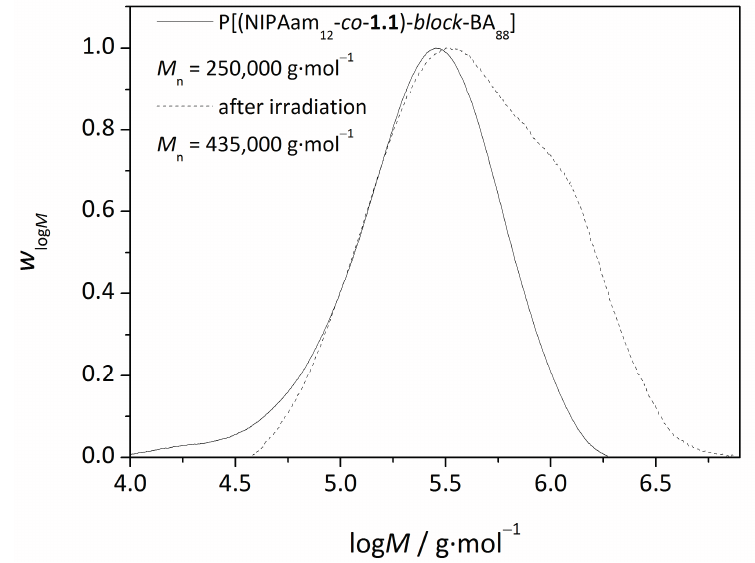
Figure 9. SEC-data, determined in THF, of a starpoly [(NIPAam- co - 1.1 ) 12 - block -BA 88 ] with a molecular weight of 250,000 g·mol − 1 (solid line) and the resulting polymer ( M n = 435,000 g·mol − 1 ) after UV-irradiation (dashed line) for 57 h using a UV hand lamp of 8 W in